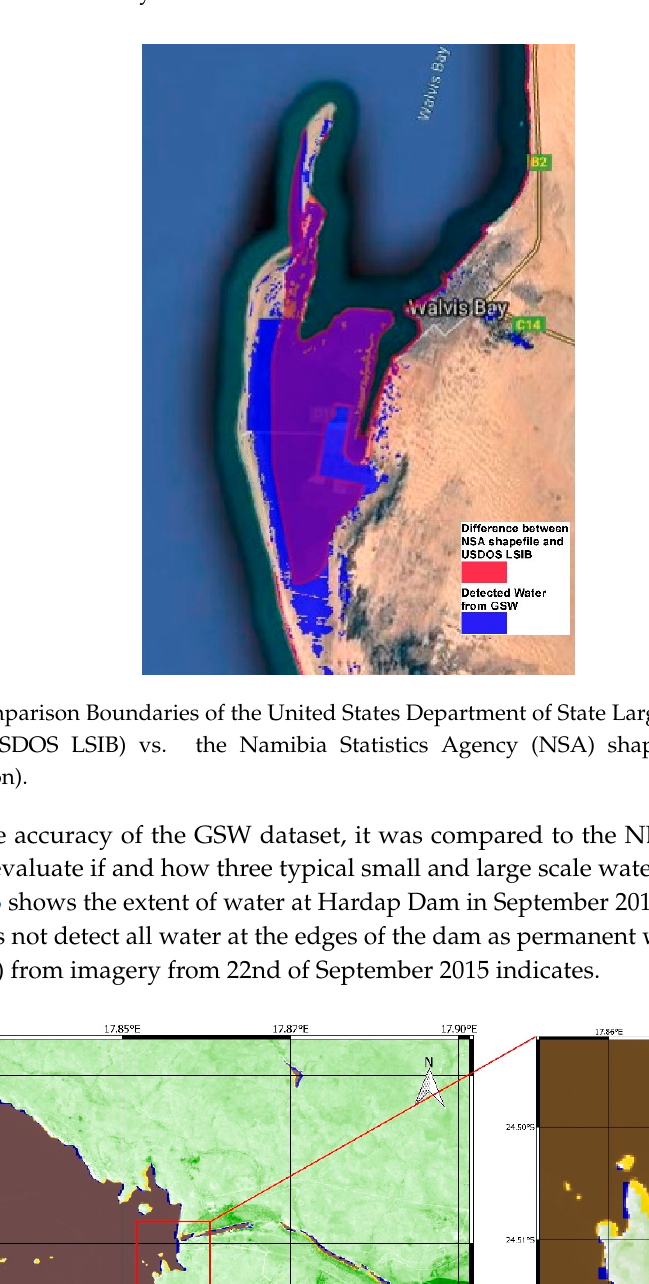
Figure 1. Comparison GSW 5-year average for Namibia with different shapefiles.